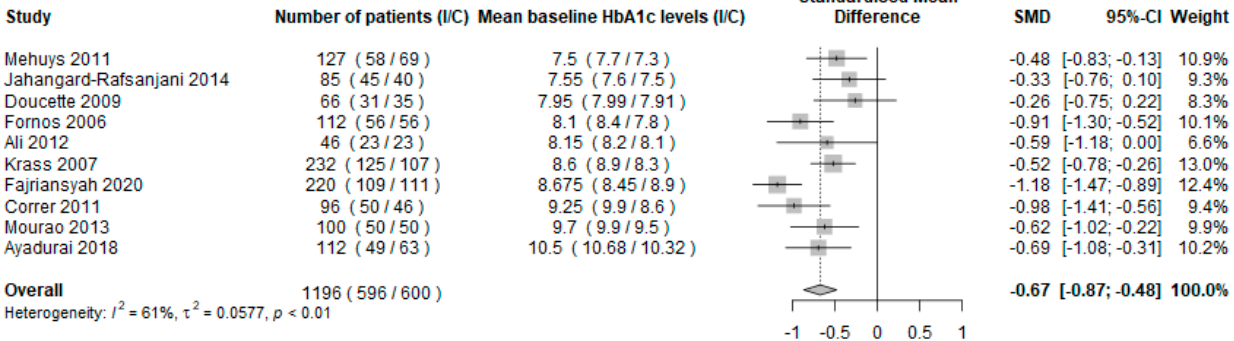
Figure 2. Forest plot of the mean difference in HbA1c levels in the intervention group compared with the usual pharmaceutical care group using random effects model. Abbreviations: I = intervention group; C = control group; HbA1c = glycated haemoglobin.